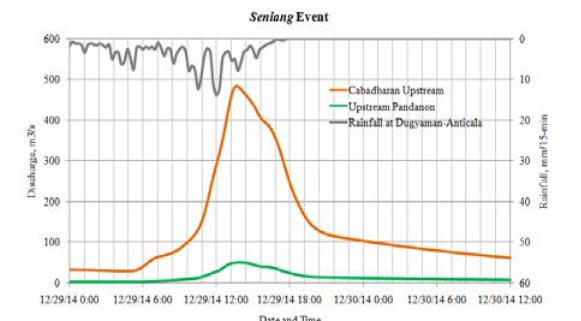
Figure 4. Discharge hydrographs simulated by the HEC HMS model for Cabadbaran Upstream and Pandanon Upstream for the Seniang